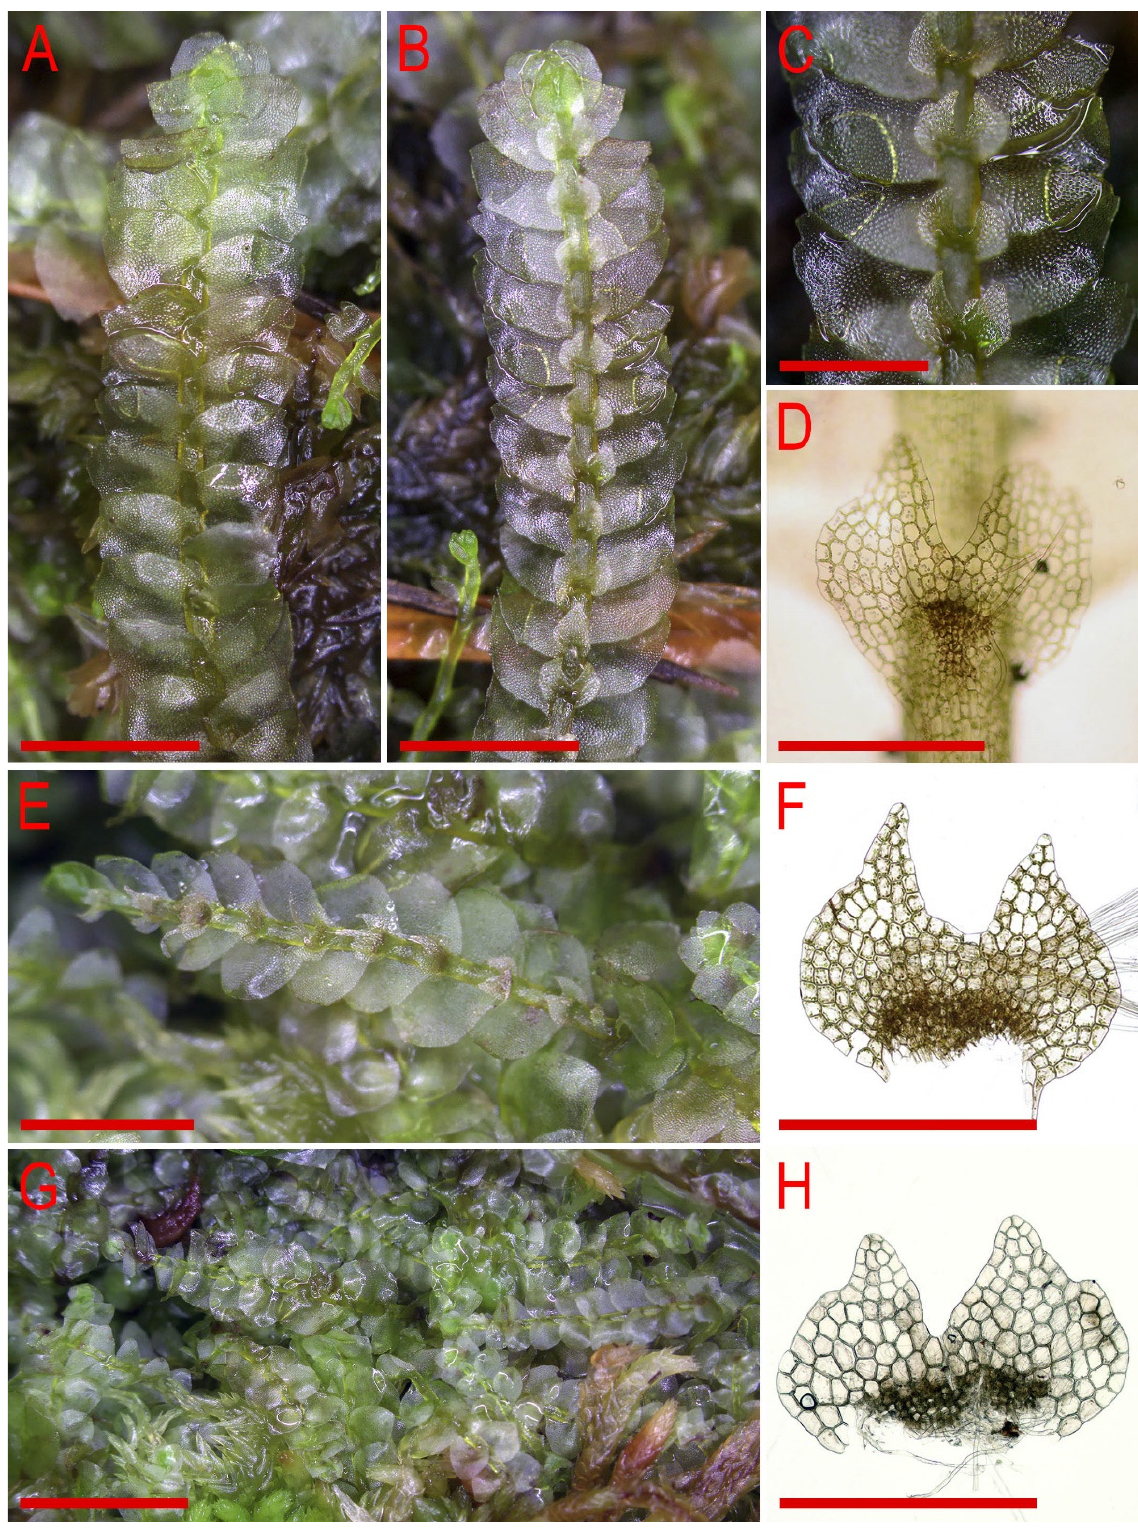
Figure 20. Calypogeia kamchatica Bakalin, Troizk. et Maltseva, sp. nov. : ( A ) Plant habit, fragment, dorsal view; ( B , C , E ) Plant habit, fragment, ventral view; ( D , F , H ) Underleaves; ( G ) Mat. Scales: 2 mm for ( A , B , E ); 1 mm for ( C ); 5 mm for ( G ); 500 μ m for ( D , F , H ). ( A – C ) From K-70-11-15; ( D ) From K-63-3-15; ( E , G ) From K-70-12-15; ( F , H ) From K-58-7-18. All from VBGI.